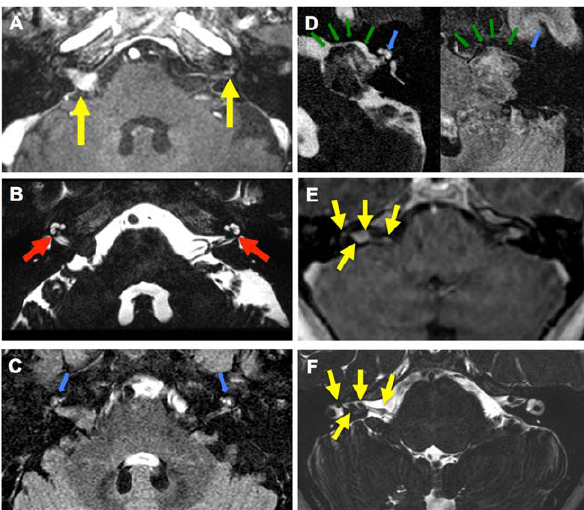
Figure 2. Magnetic resonance imaging in patients with neurofibromatosis type 2. Magnetic resonance (MR) imaging performed in a 47-year old patient with neurofibromatosis type 2 (NF2): (A) Axial, contrast enhanced, T1-weighted, magnetic resonance imaging demonstrates bilateral cochleovestibular schwannomas (CVS) (yellow arrows). (B) T2-VISTA sequence identifies the presence of a cerebrospinal fluid obstruction between the posterior fossa and the cochlear aperture (red arrows) bilaterally, independent of tumor size. (C) Pre-contrast fluid attenuated inversion recovery (FLAIR) sequence demonstrates the presence of elevated protein within the labyrinth (blue arrows). MR-imaging performed in a 48-year old patient with NF2: (D) Axial T2-VISTA and pre-contrast FLAIR sequences demonstrate the presence of normal labyrinthine protein (blue arrow) in the setting of a large CVS with an open CSF pathway (green arrows) between the posterior fossa and the cochlear aperture. MR-imaging performed in a 8-year old patient with NF2. (E) Axial, contrast enhanced, T1-weighted, magnetic resonance imaging demonstrates bilateral cochleovestibular schwannomas (CVS) with multiple tumors present on the right (yellow arrows). (F) T2-VISTA sequence identifies 4 discrete tumors, including a discrete intralabyrinthine tumor (yellow arrows).